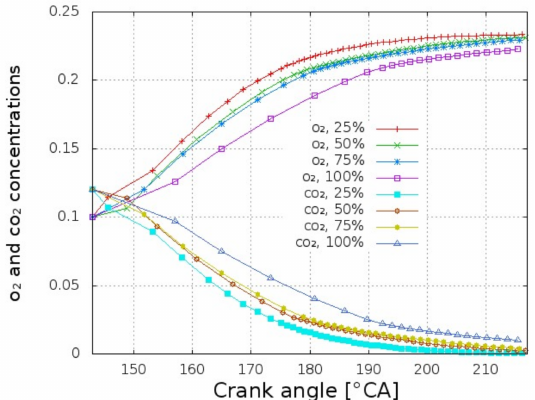
Figure 7. The variation of the concentration of O 2 and CO 2 over time for different engine loads. The axial momentum of the working media through the cylinder is shown in Figure